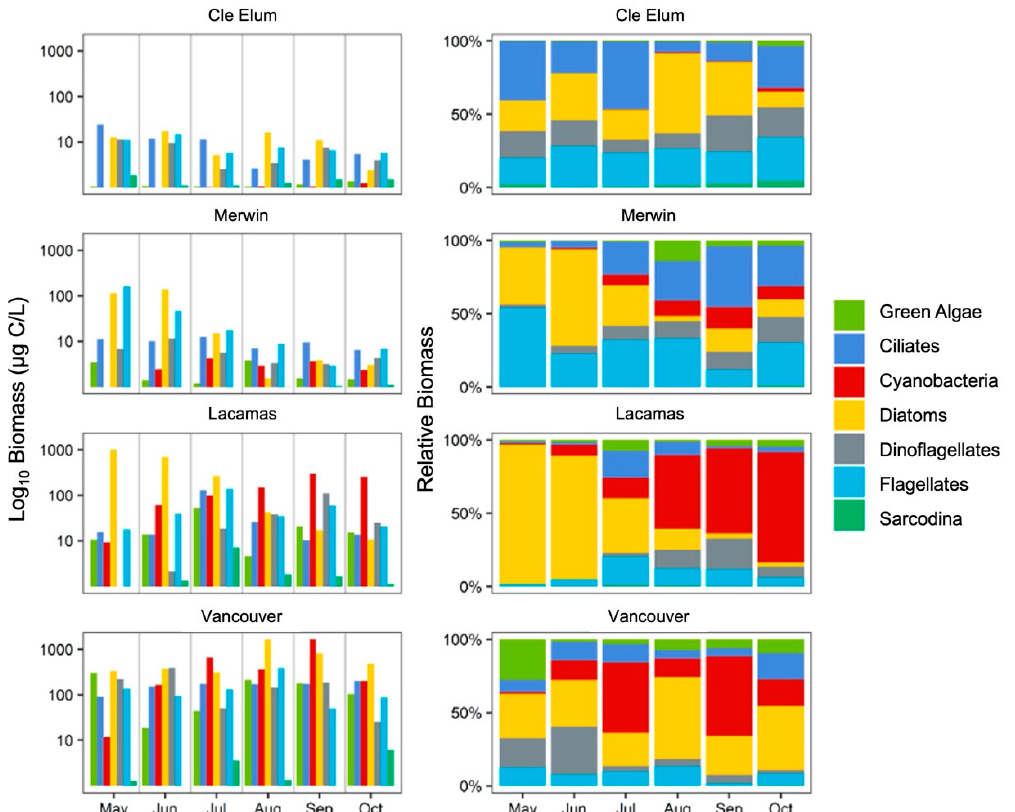
Figure 4. Microplankton absolute biomass (shown on a log 10 scale in left panels) and relative biomass (right panels), binned into seven major taxonomic categories, in monthly samples collected from Cle Elum, Merwin, Lacamas, and Vancouver lakes from May through October 2014.